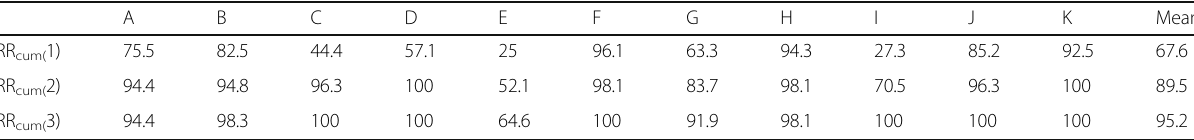
Table 3 Cumulative recognition rates for HTI 2014 – 2015